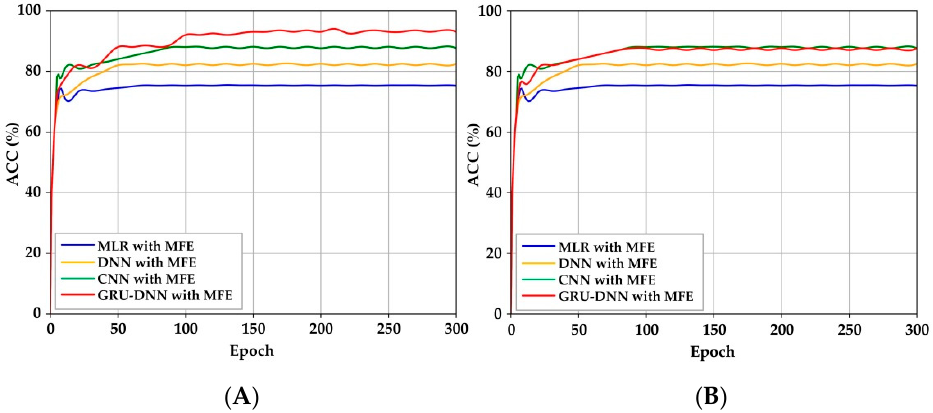
Figure 11. ACCs of four models in training and validation sets. ( A ) training set; ( B ) validation set.